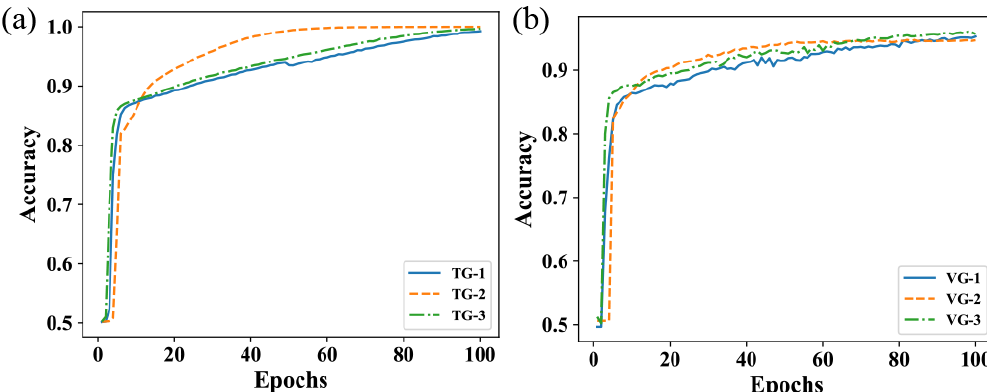
Figure 14. Evolutional curves of the prediction accuracy of the proposed DCNN model for NWPO images, with the (a) training process and (b) validation